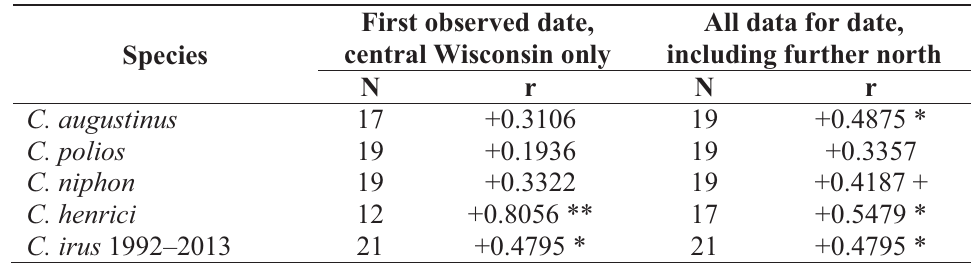
Table 7. Spearman rank correlation coefficients (r) of trend over time (correlations with year) in consecutive-year change in first observed date (absolute value N days change between the prior year ’ s and the current year ’ s first observed date), by species. Dates are calculated both using surveys only in central Wisconsin and using all survey data including from northern Wisconsin and northeastern Minnesota. + p < 0.10, * p < 0.05, ** p < 0.01, *** p <